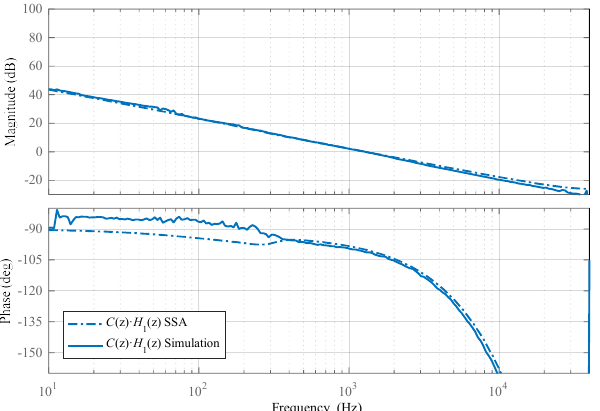
Figure 20. Frequency response of the converter with the designed controller C(z) ∙ H 1 (z) (PM = 80 deg, f t = 1.29 kHz).